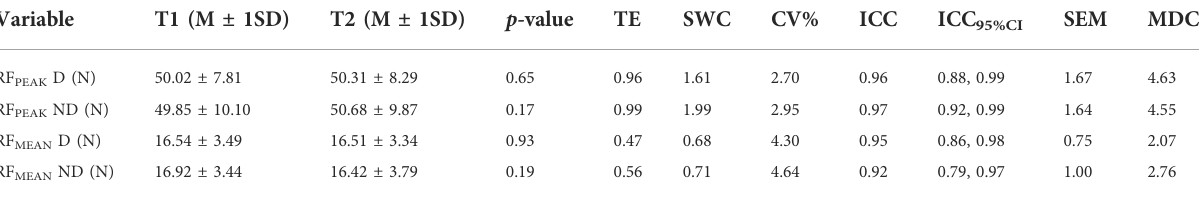
TABLE 1 Test-retest reliability of the Aquanex System in young competitive swimmers. Variable